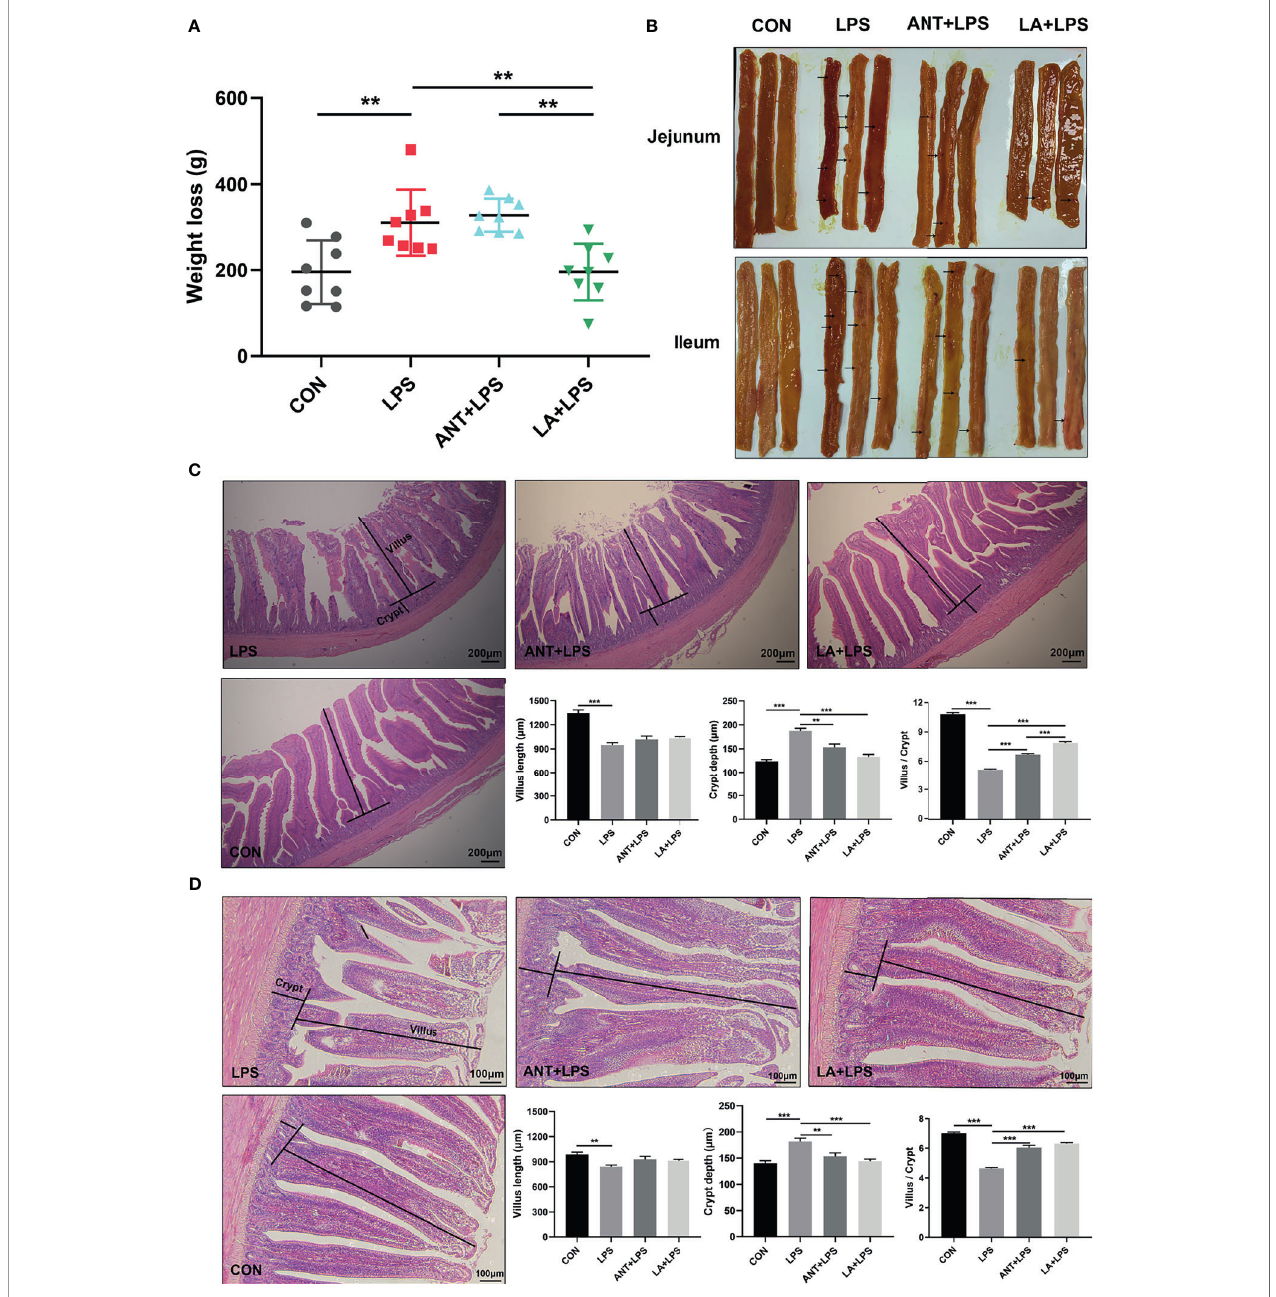
FIGURE 1 | Lauric acid (LA) attenuated the weight loss and intestinal injuries of lipopolysaccharide (LPS)- challenged broilers. CON: fed with a basal diet and injected with saline; LPS: fed with a basal diet and injected with 0.5 mg/kg LPS; ANT+LPS: fed with a basal diet supplemented with 75 mg/kg ANT, and injected with 0.5 mg/kg LPS; LA+LPS: fed with a basal diet supplemented with 1000 mg/kg LA, and injected with 0.5 mg/kg LPS. N=8 in each group. (A) Weight loss. Weight loss was calculated using the equation: weight on day 42 - weight on day 44. (B) Pictures of the jejunal and ileal lumen. The arrows indicates the hemorrhagic spots. (C) Histomorphometric analysis of the jejunum by Hematoxylin & Eosin (H&E) staining. 40× magni fi cation, scale bar: 200 m m. (D) Ileum histomorphometric analysis. 100× magni fi cation, scale bar: 100 m m. The villus height and crypt depth shown in the pictures were randomly measured in 10 visual fi elds in each sample from each group. The data shown as mean ± SEM were analyzed using one-way ANOVA and Tukey ’ s test. ** P < 0.01, *** P <